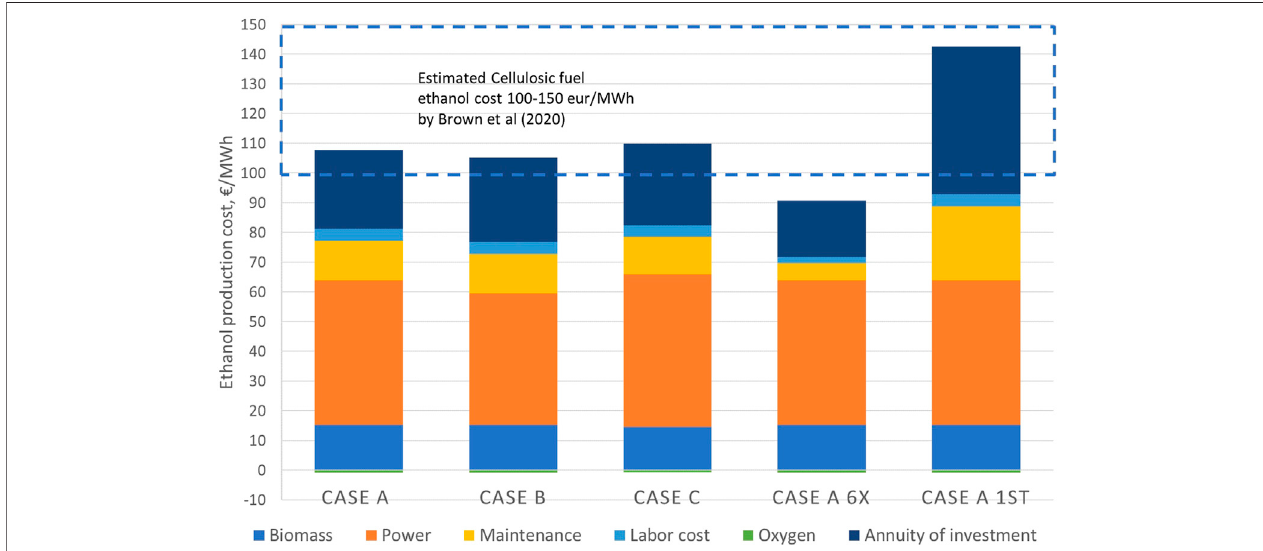
FIGURE 7 | Levelized cost of ethanol for the cases A, B and C, and additional cases A 6x (6-fold production capacity of case A) and case A fi rst (cost estimate corresponding to fi rst-of-kind plant.).